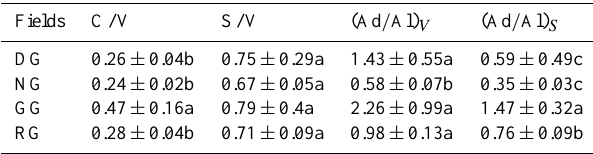
Table 2. Source and degradation parameters of lignin phenols in grassland soils in Inner Mongolia. DG: degraded grassland by overgrazing; NG: native grassland without apparent anthropogenic disturbance; GG: groundwater-sustaining grassland; RG: restored grassland from previous cultivated land. Four soil samples were an- alyzed for each type